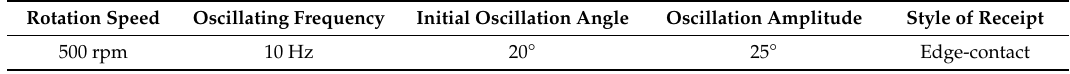
Figure 13. Non-uniformity of material removal for different parameters, where the group of parameters which can achieve uniform polishing is marked.